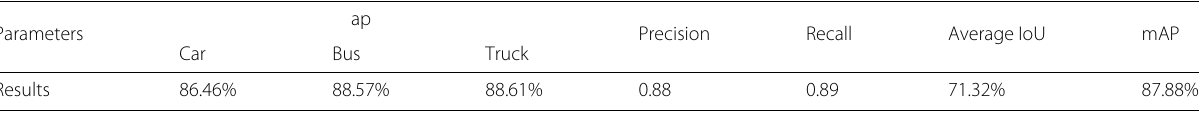
Table 4 Accuracy of the network